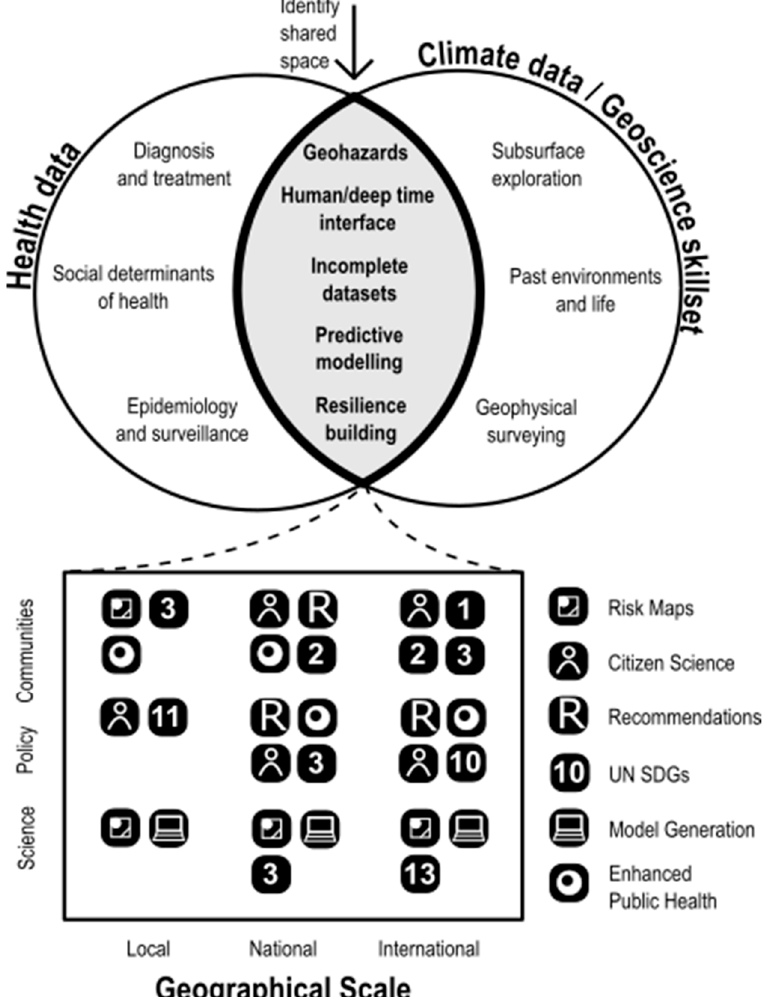
Figure 1. Conceptualization of the shared space between health and climate/earth science, together with benefits to different stakeholders across different scales. The numbered icons (1, 2, 3, 10, 11, 13) refer to the UN Sustainable Development Goal most relevant to the sector/geographic scale indi- cated.